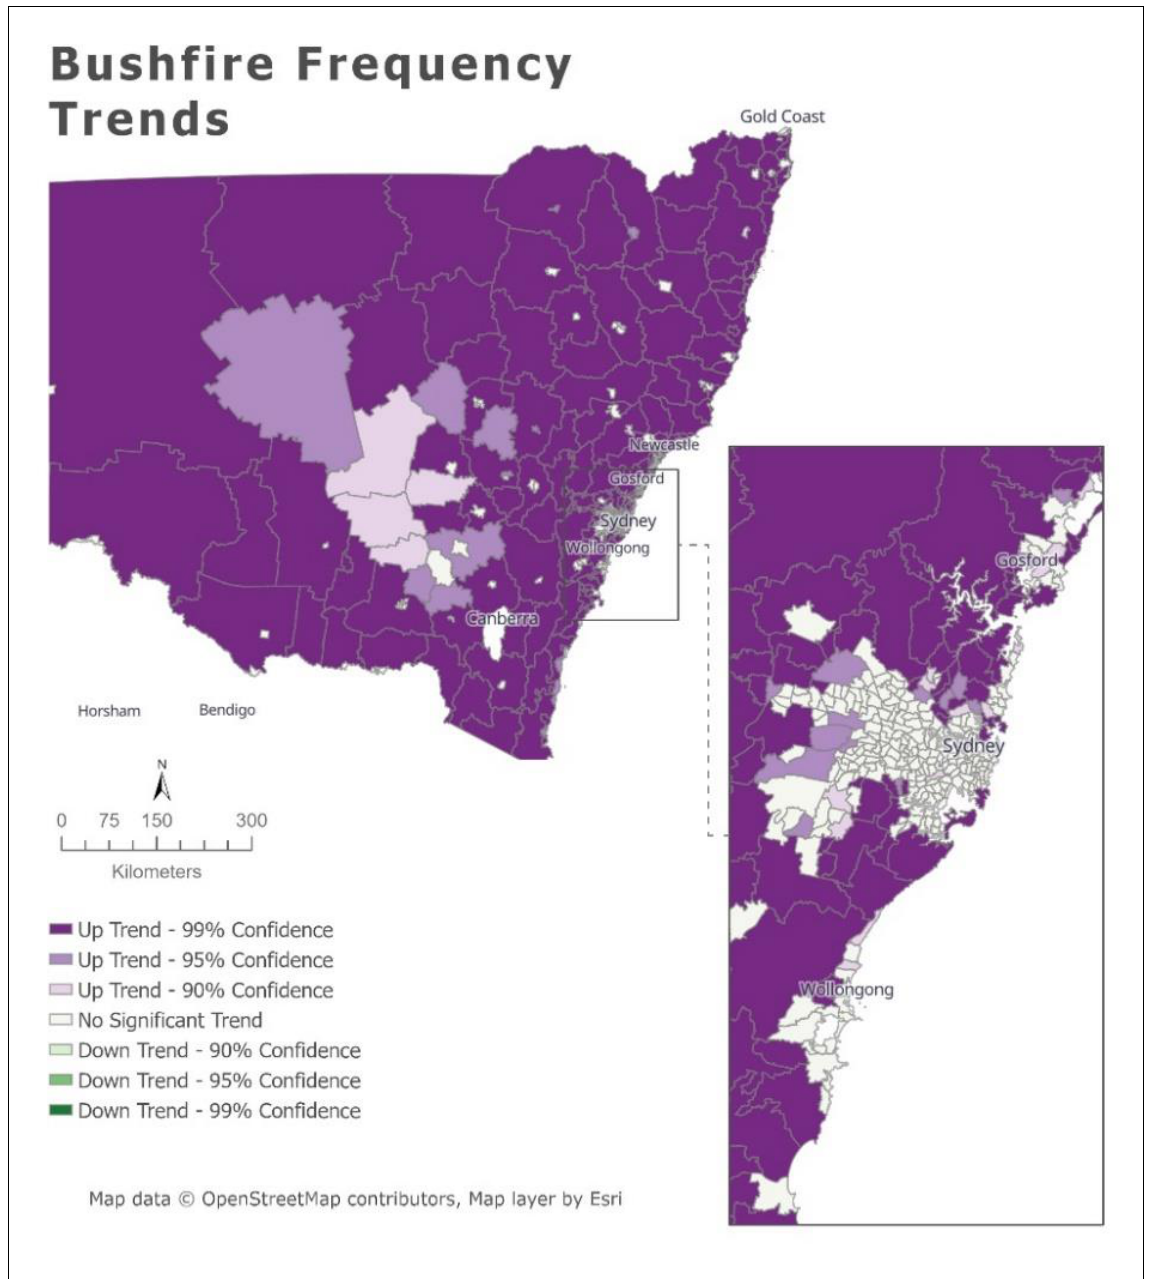
Figure 17. Bushfire frequency trends for each SA2.